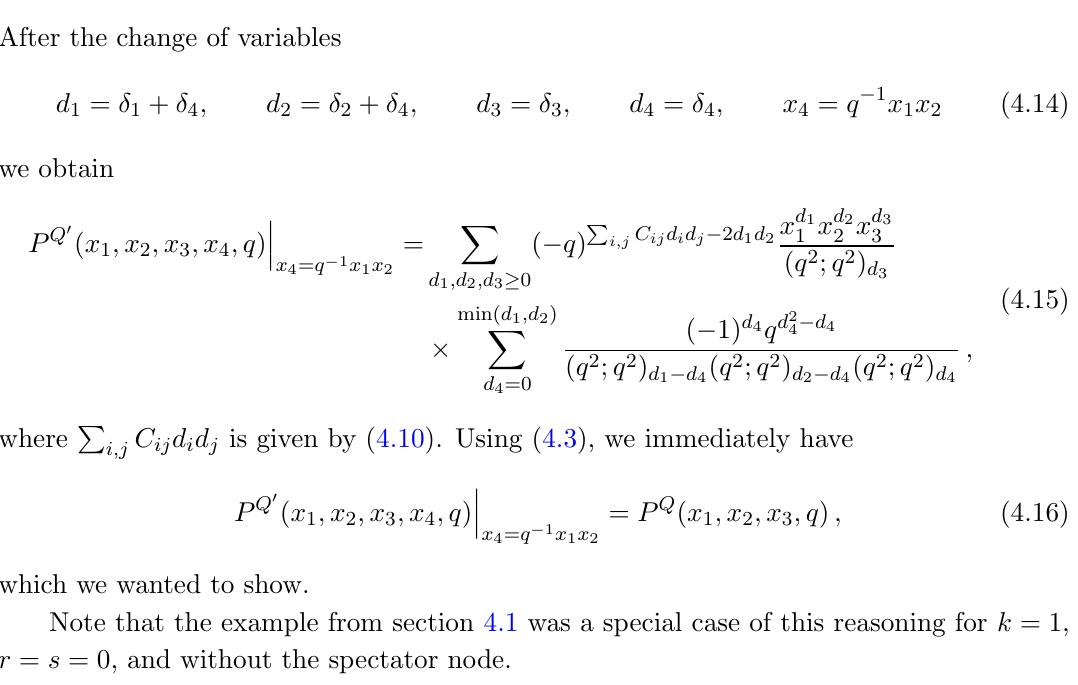
Figure 4. Unlinking | general case. Numbers next to lines and loops denote the number of pairs of arrows and the number of loops